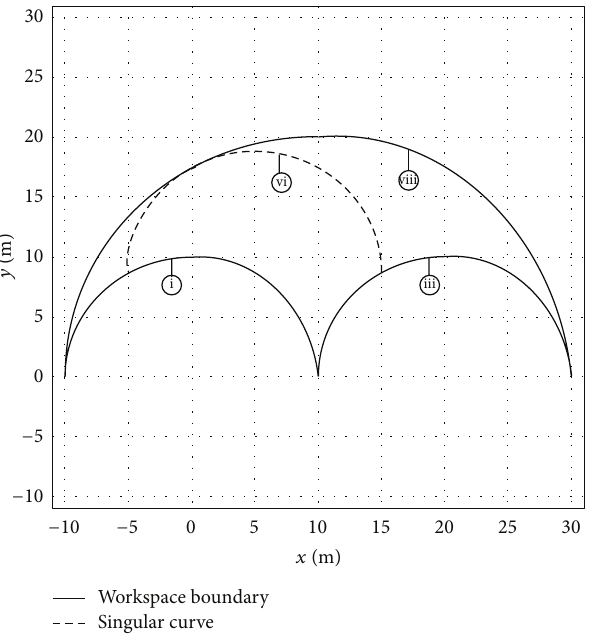
Figure 3: Output workspace and singular curves for the planar 4- bar tensegrity mechanism with 𝐿 = 10